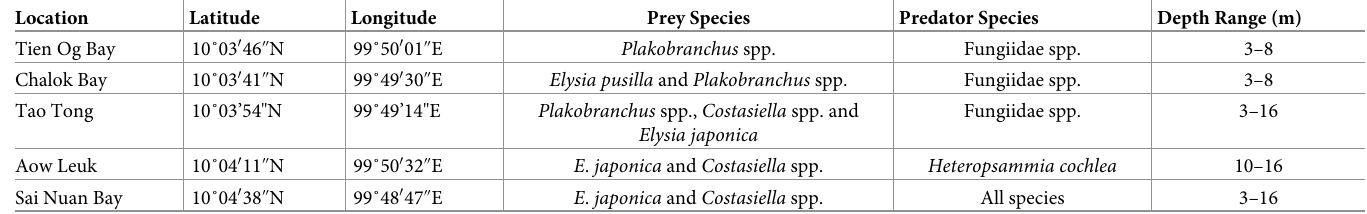
Table 1. Sampling sites at Koh Tao, Gulf of Thailand, indicating which predator and prey species were sampled from which location and total depth range of sam- pling. In-situ trials were conducted at all sites. Location